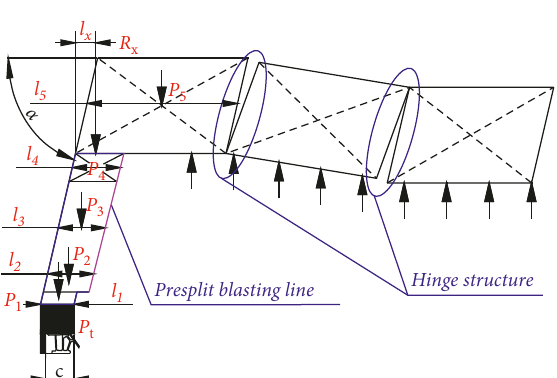
Figure 6: Mechanical model of the combined cantilever beam after presplitting.